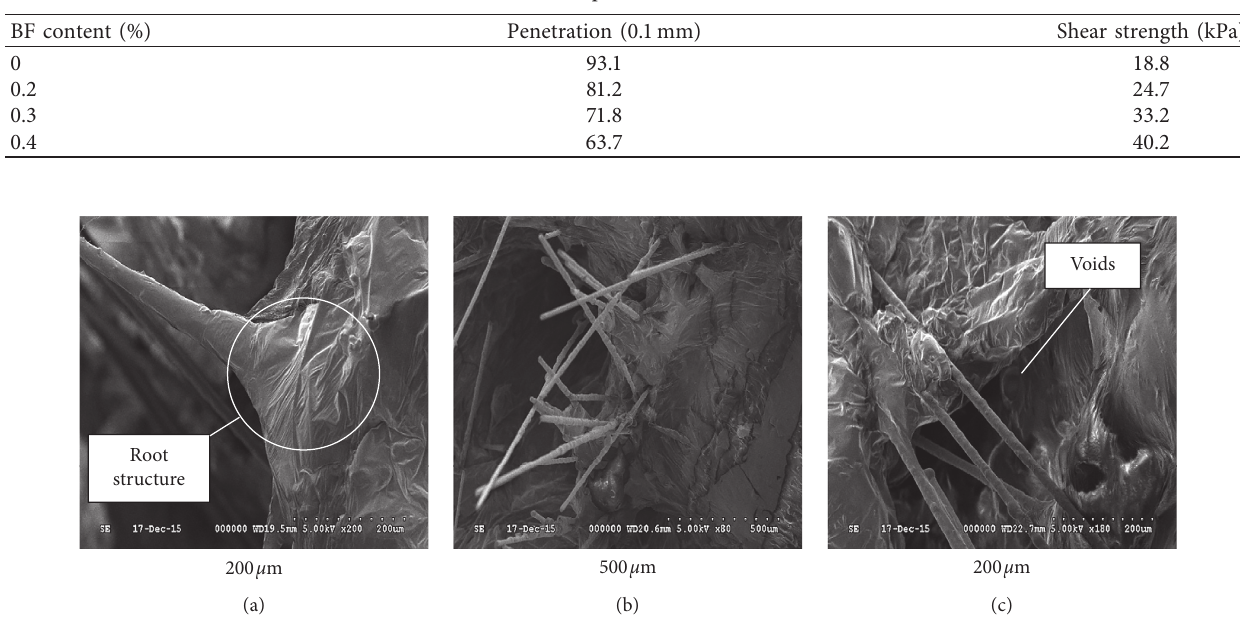
Figure 10: Scanning by SEM. (a) Saturated BF surface with asphalt binder. (b) Distribution of BF in asphalt binder. (c) Bridging over